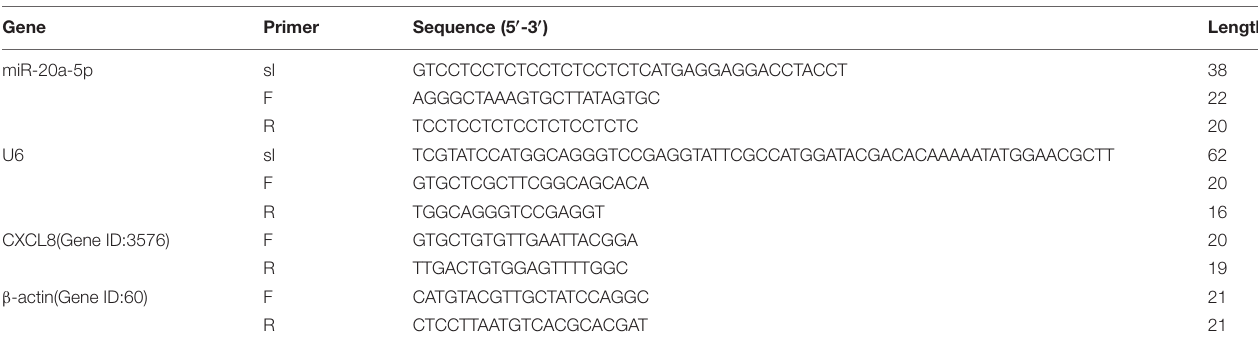
TABLE 1 | Primer sequence for